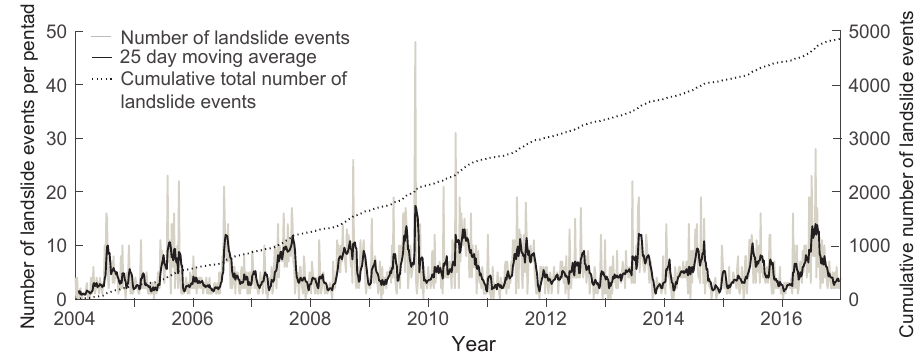
Figure 2. The occurrence of non-seismically triggered landslide events from 2004 to 2016, and cumulative total of recorded events. The data are arranged by pentads (5-day bins), starting on 1 January each year; thus the first pentad includes records for 1–5 January, and there are a total 73 pentads. A simple 25-day moving average is shown.